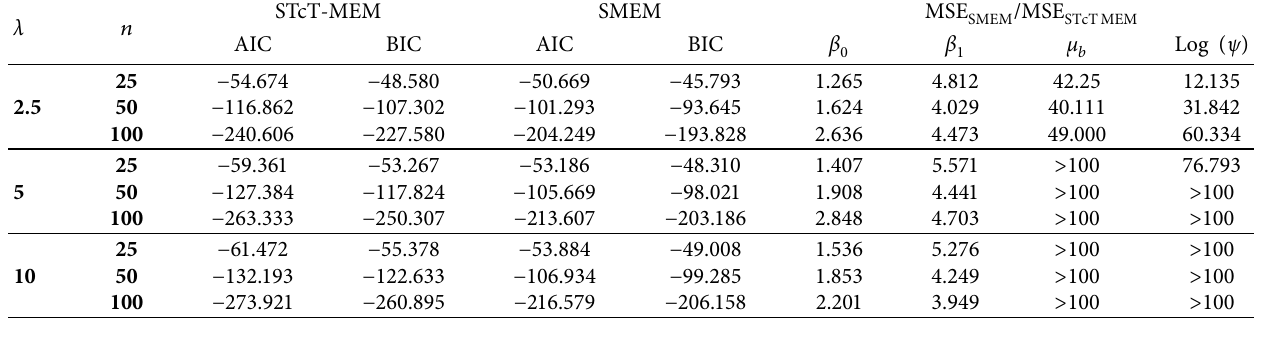
Table 3: AIC and BIC values while the STcT-MEM is the data generating model and relative efciencies of STcT-MEM based estimators relative to the SMEM.